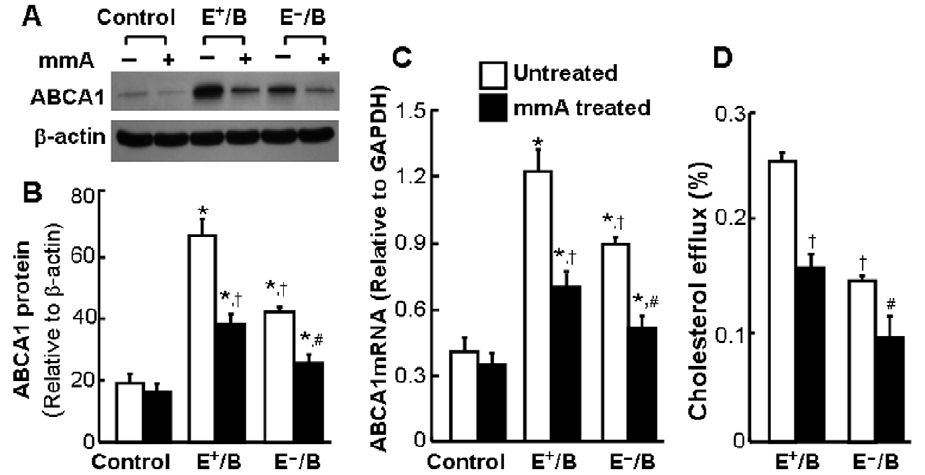
Figure 5. The effect of mithramycin A on lipoprotein-induced ABCA1 expression and cholesterol efflux. For study ABCA1 expression, mouse macrophages were treated with 20 m g/ml of wild-type (E + /B), ApoE-free (EI ˆ /B) or ApoE3-enriched (E3/B) lipoproteins, or culture medium (control) in the presence or absence of 100 nM mithramycin A (mmA) for 4 hrs. Panel A and B: The level of ABCA1 protein was determined by western blot analysis and quantitated relative to b -actin. Panel C: The level of ABCA1 mRNA was determined by quantitative real-time RT-PCR and normalized to GAPDH mRNA. Panel D: For studying cholesterol efflux, mouse macrophages were incubated with [ 3 H]-cholesterol in the presence or absence of 20 m g/ml of E + /B, E 2 /B or E3/B lipoproteins for 24 hrs. ApoAI-mediated cholesterol efflux was measured in the presence or absence of mmA. Values represent the mean 6 SEM of five independent experiments. * P , 0.05 compared to control, { P , 0.05 compared to cells treated with E + / B lipoproteins and without mmA, and # P , 0.05 compared to cells treated with E 2 /B lipoproteins and without